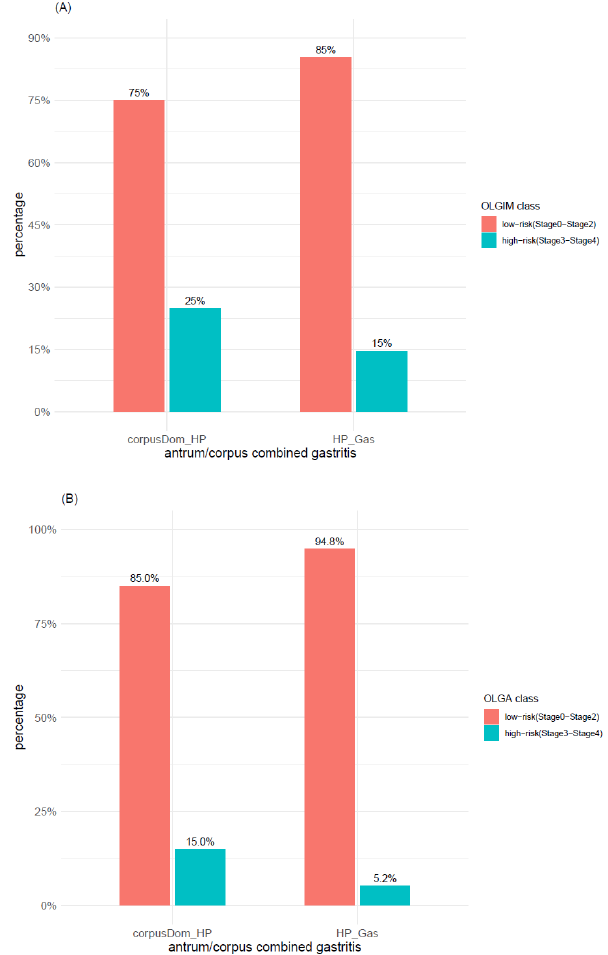
Figure 10. Comparison of H. pylori and Corpus dominant H. pylori gastritis with regard to ( A ) intestinal metaplasia and ( B ) atrophy. OLGA and OLGIM classes are grouped as low-risk and high-risk. corpusDom_HP: Corpus Dominant H. pylori Gastritis; HP_Gas: H. pylori Gastritis; OLGA: operative link on gastritis assessment; OLGIM: operative link on gastric intestinal metaplasia assessment.